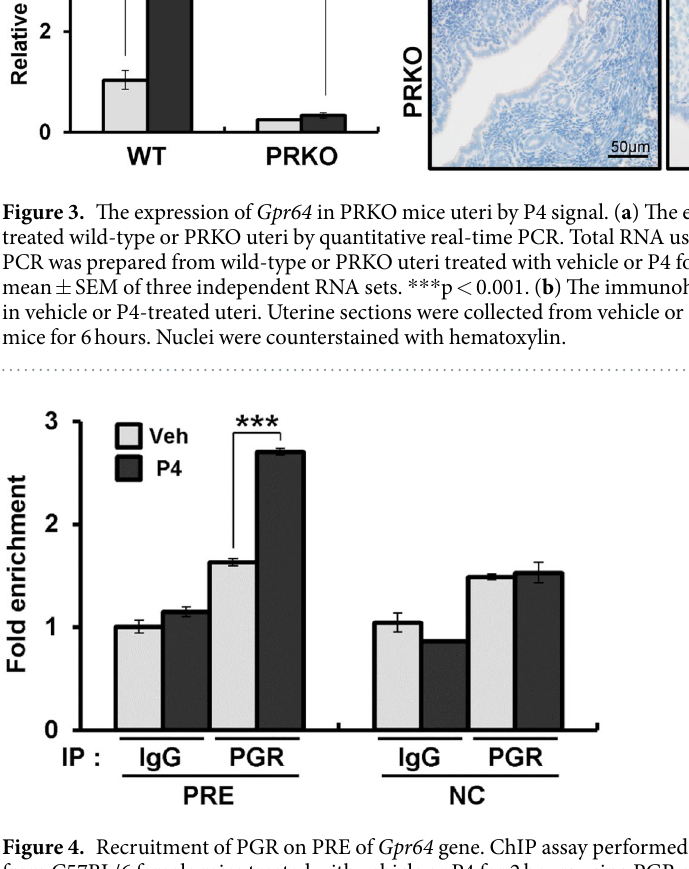
Figure 4. Recruitment of PGR on PRE of Gpr64 gene. ChIP assay performed with uterine chromatin isolated from C57BL/6 female mice treated with vehicle or P4 for 2 hours using PGR antibody followed by quantitative real-time PCR. A normal rabbit IgG antibody was used as the negative control. NC region on the Gpr64 gene was used as negative control of ChIP assay. The results represent the mean ± SEM. *** p <